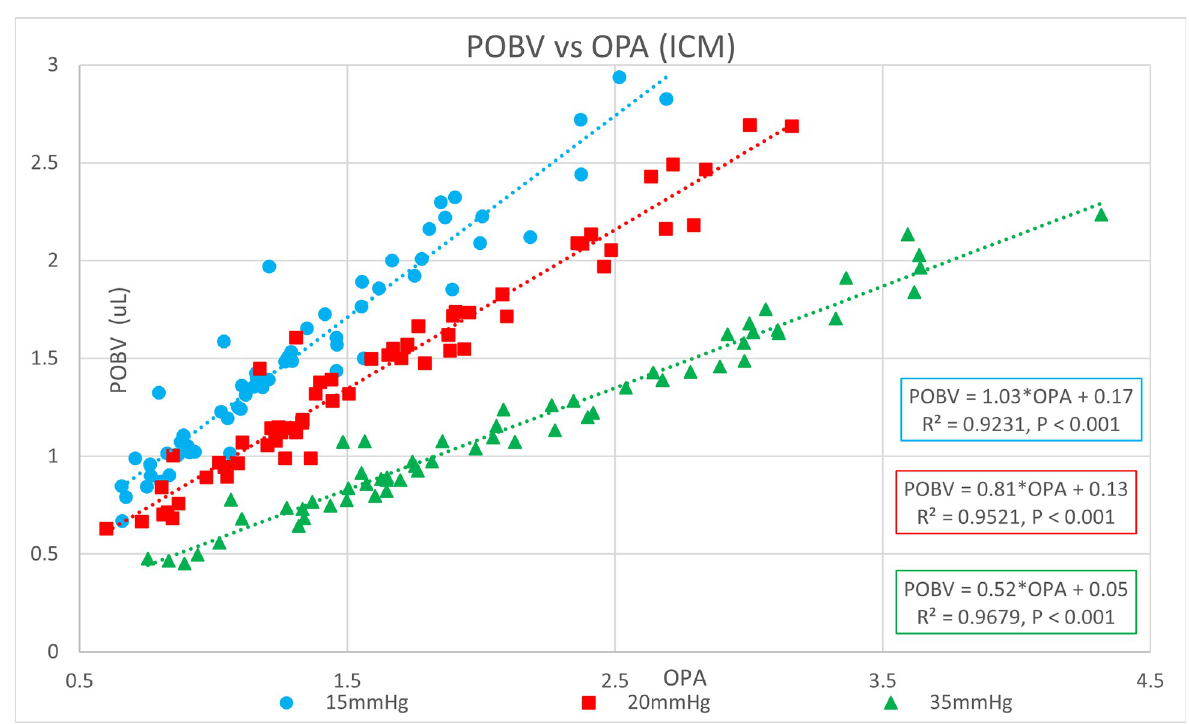
Fig 4. Positive correlation of POBV to OPA for ICM measurements.